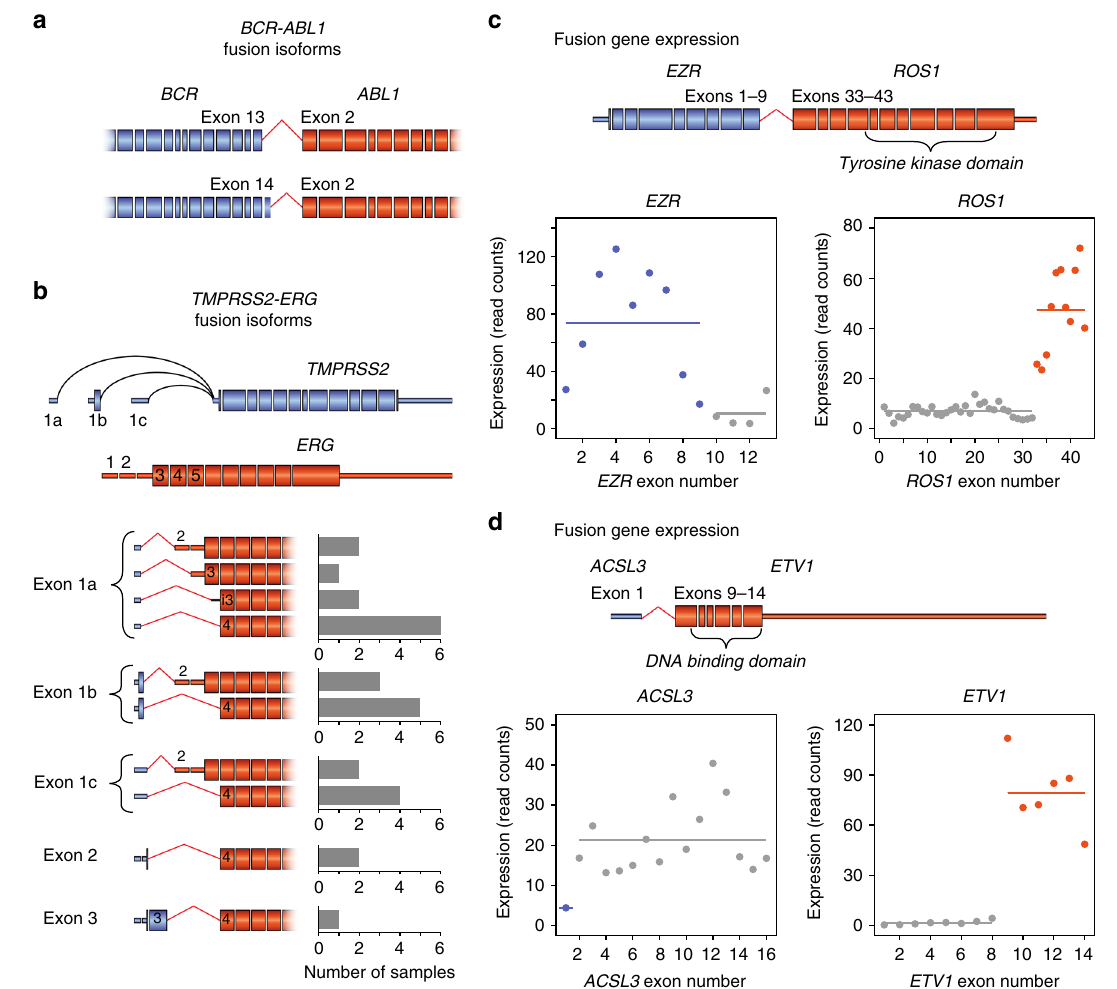
Fig. 4 Fusion junction diversity and gene expression. a Schematic of BCR-ABL1 fusion isoforms + / − BCR exon 14. b TMPRSS2 and ERG gene structures and TMPRSS2-ERG fusion isoform prevalence. Bar charts on the right indicate the number of samples expressing each isoform. For simplicity, junctions beyond exon 1 are depicted utilising exon 1a. Black line represents retained intronic sequence. c , d Schematic of EZR-ROS1 and ACLS3-ETV1 fusions and quanti fi cation of read count expression across the endogenous genes in lung cancer sample MO-16-000393 and prostate cancer sample 12543, respectively. Horizontal lines indicate mean expression levels; coloured dots represent expression from the fused alleles plus nonrearranged alleles, while the grey dots represent expression of the canonical, nonrearranged